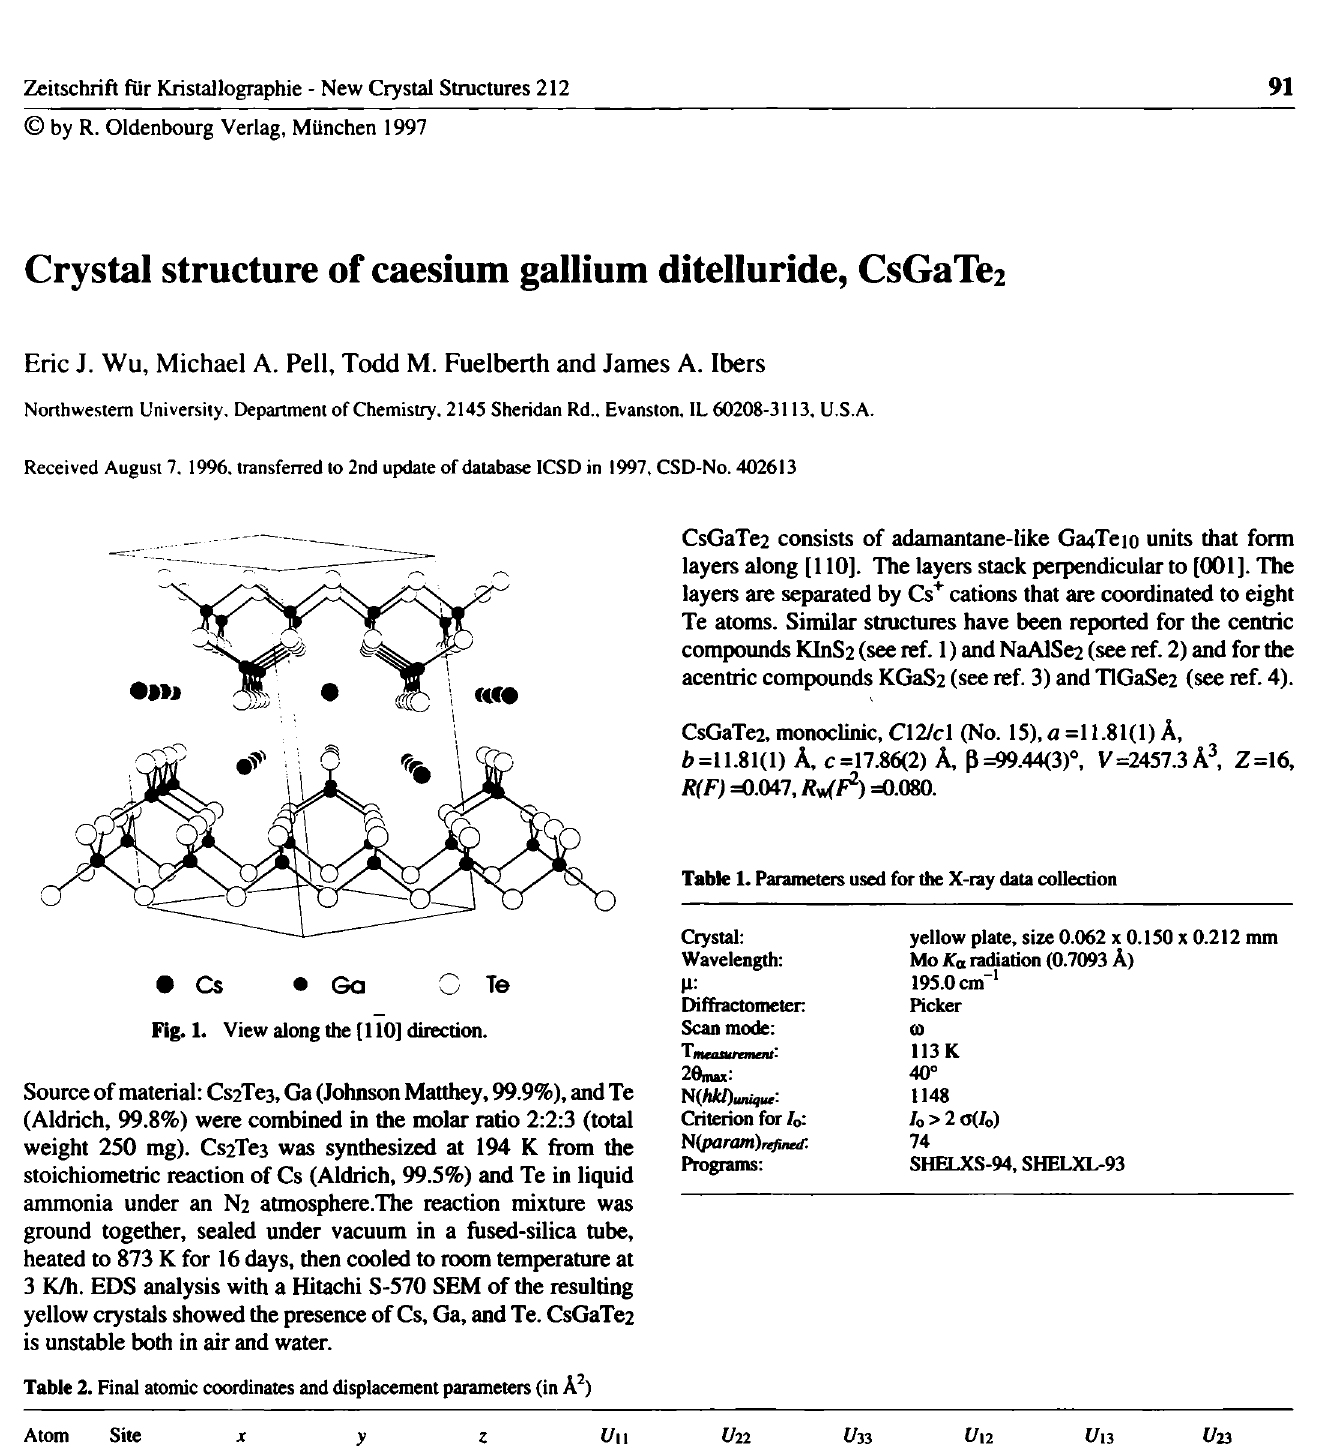
Table 2. Final atomic coordinates and displacement parameters (in À 2 )